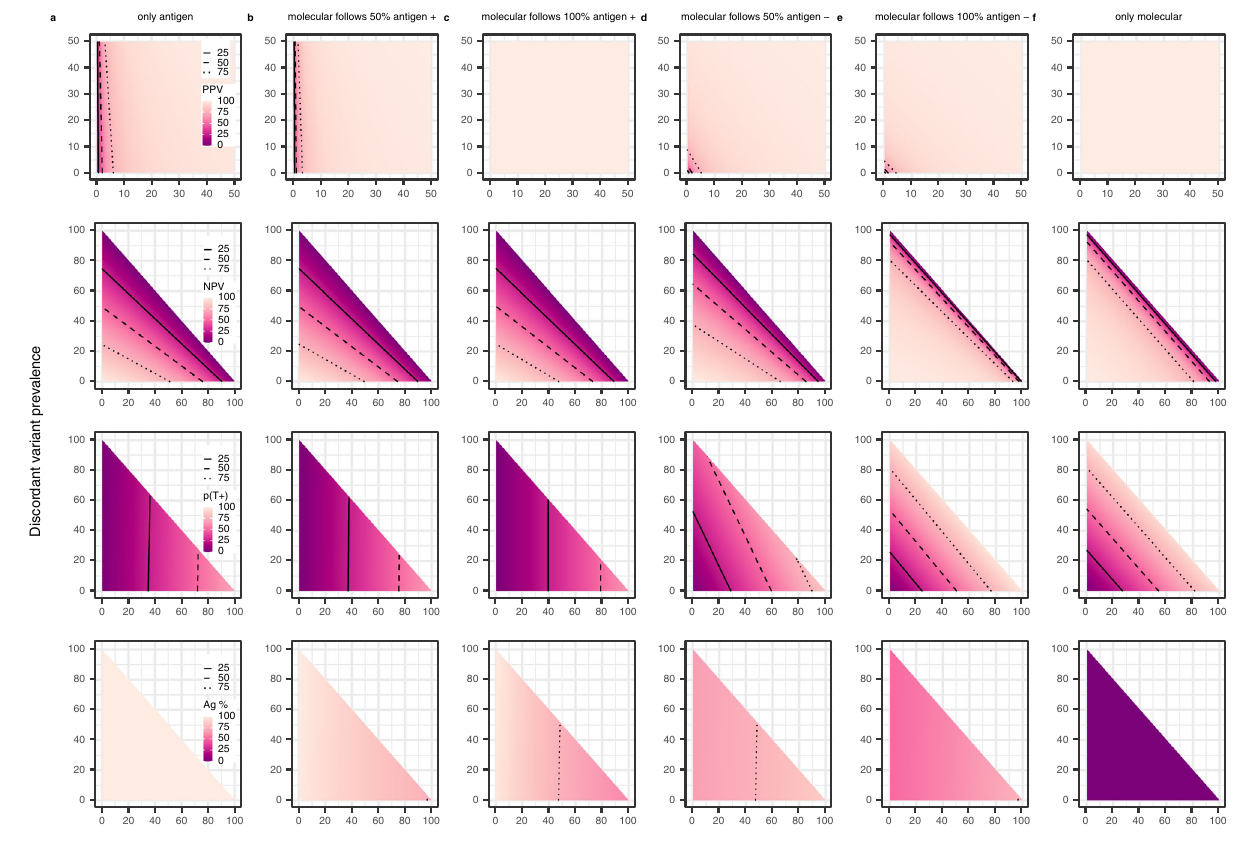
Fig. 6 | Performance ofantigenand moleculartesting strategies,givena range ofconcordant and discordant variant prevalencevalues. a Individuals present for diagnosis with an antigen test and there is no molecular test con fi rmation. b Individuals present for diagnosis with an antigen test and 50% of positive cases are con fi rmed with a molecular test. c Individuals present for diagnosis with an antigen test and all positive cases are con fi rmed with a molecular test. d Individuals present for diagnosis with an antigen test and 50% of negative cases are con fi rmed with a molecular test. e Individuals present for diagnosis with an antigen test and all negative cases are con fi rmed with a molecular test. f Individuals present for diagnosis with a molecular test. Presented are the